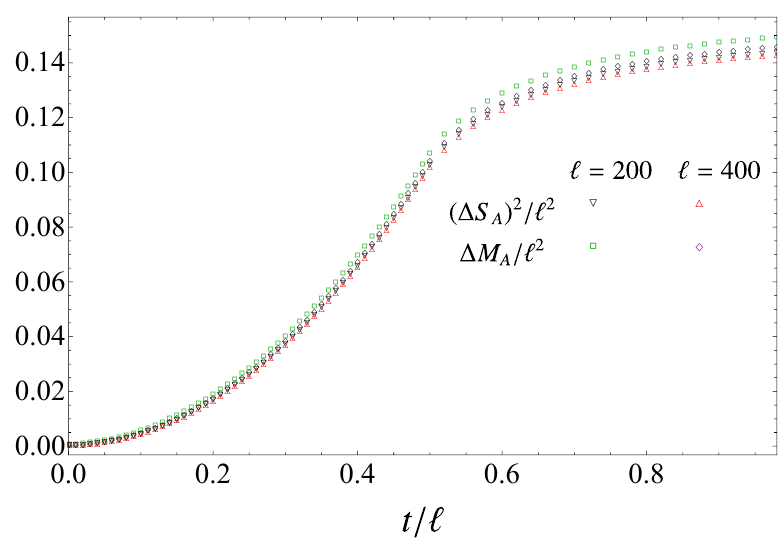
Figure 8 . Temporal evolution of ∆ M A and of (∆ S A ) 2 of a block of ‘ consecutive sites in the infinite fermionic chain, after a quantum quench from the fully dimerised chain to the homogeneous gapless